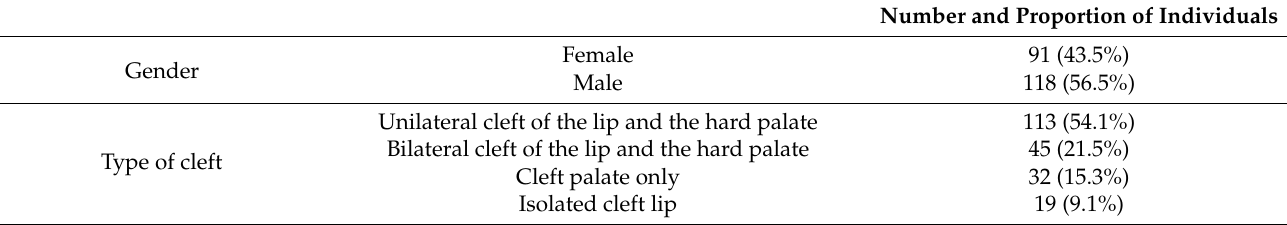
Table 2. Characteristics of patients with NSCL/P.